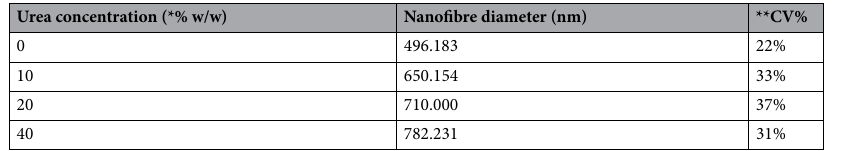
Table 1. Effect of urea concentration on electrospun nanofibre diameter. *% w/w based on amount of PLLA used. **Coefficient of Variation (CV).